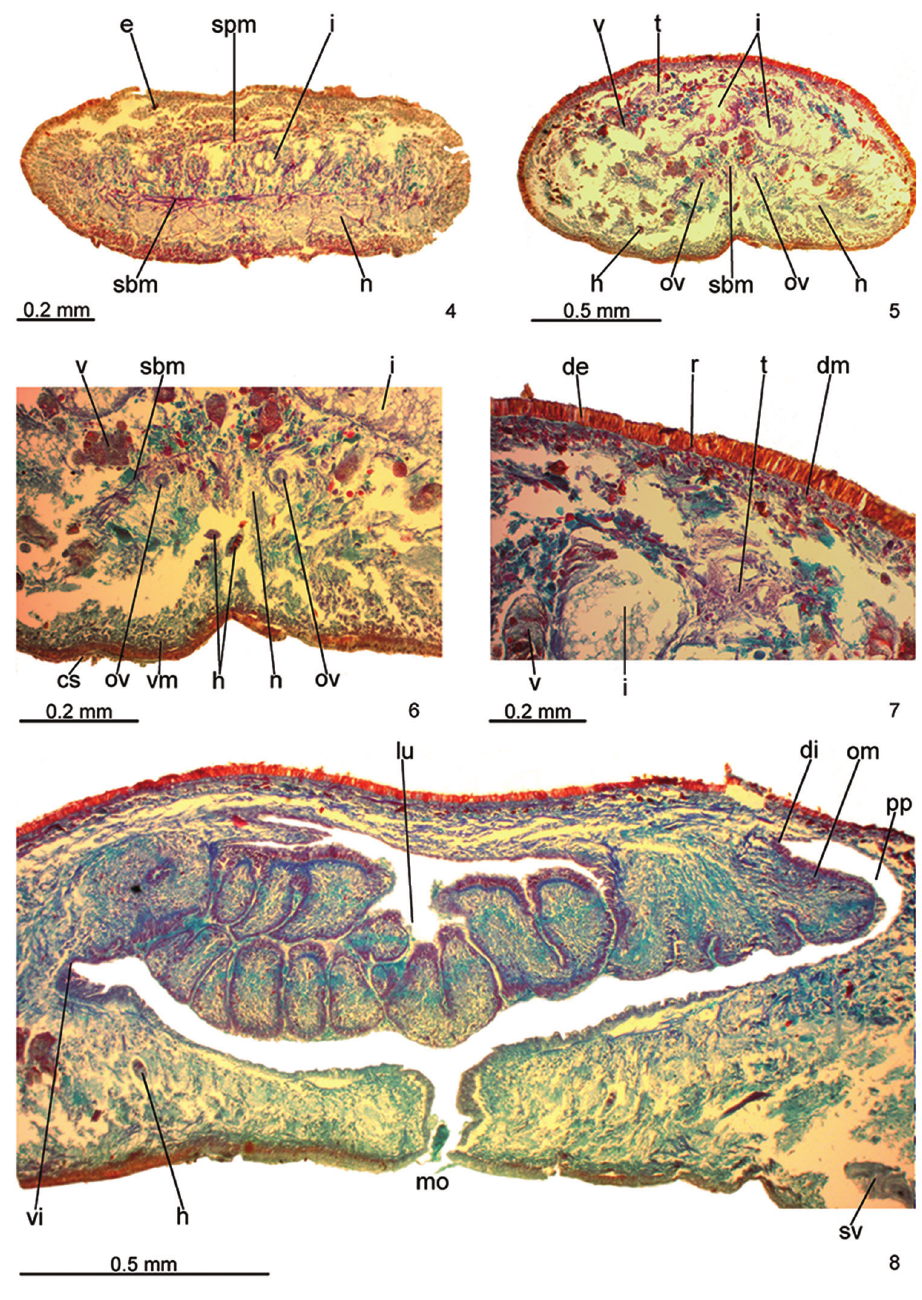
Figures 4–8. Pasipha ferrariaphila sp. n., holotype. 4 anterior region, transverse section 5–7 pre-pharyn- geal region, transverse sections 8 pharynx, sagittal